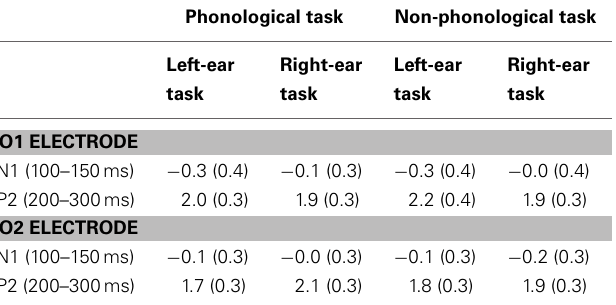
Table 4 | Mean amplitudes ( µ V, standard errors of the mean in parentheses) of N1 and P2 responses to to-be-ignore written letters, measured at O1 and O2 electrodes over time windows 100–150ms and 200–300ms from letter appearance, respectively, during auditory left-ear and right-ear phonological and non-phonological